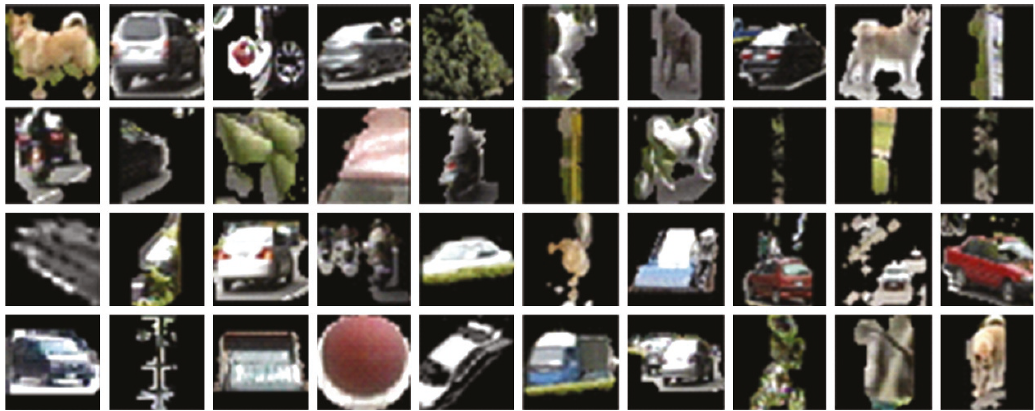
Figure 15: The negative